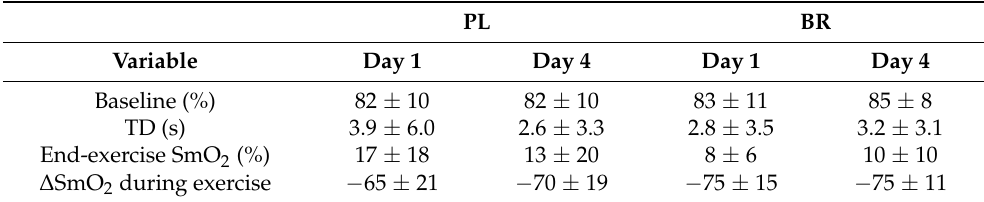
Table 5. Muscle oxygenation of the vastus lateralis during a repetitions-to-failure back squat exercise protocol for determination of muscular endurance following acute and multiday nitrate supplementation.